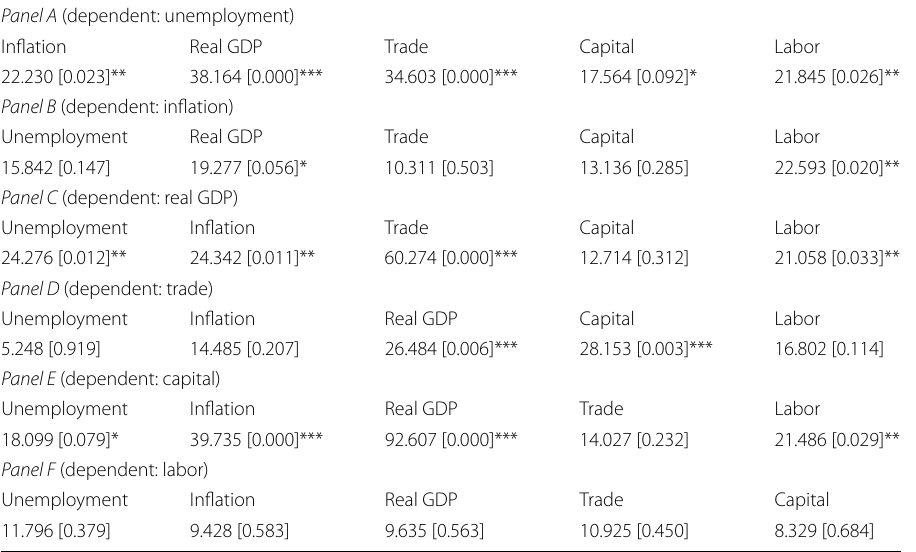
Table 4 Granger-causality test results